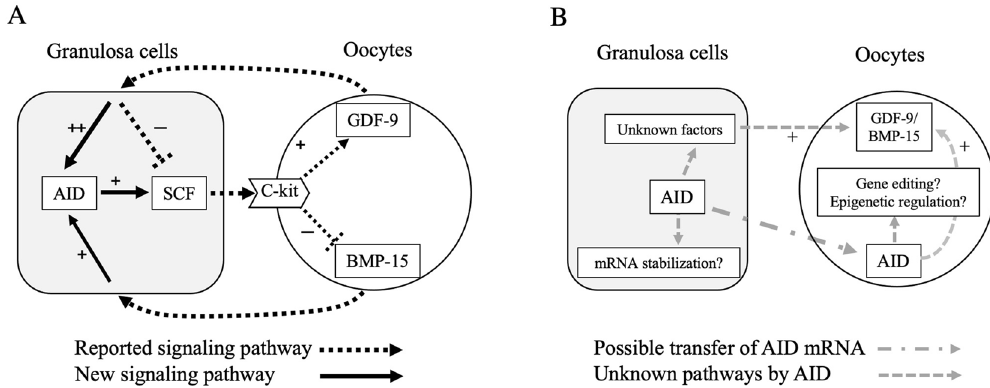
Figure 7. Estimated roles of AID in oocyte-granulosa cell communication. ( A ) Possible involvement of AID in GDF-9/BMP-15 and SCF feedback systems. It was reported that GDF-9 suppresses SCF expression in granulosa cells, whereas SCF promotes GDF-9 expression in oocytes. This study confirmed the suppressive effects of GDF-9 on SCF expression in granulosa cells. It also showed that GDF-9 promotes AID expression and AID enhances SCF expression in granulosa cells, suggesting that AID modulates the GDF-9 and SCF feedback system as a buffering role. On the other hand, SCF was reported to suppress BMP-15 expression in oocytes. In this study, although BMP-15 had no effects on SCF expression, it enhanced AID expression in cultured granulosa cells, suggesting the presence of a negative feedback system between BMP-15 and SCF via